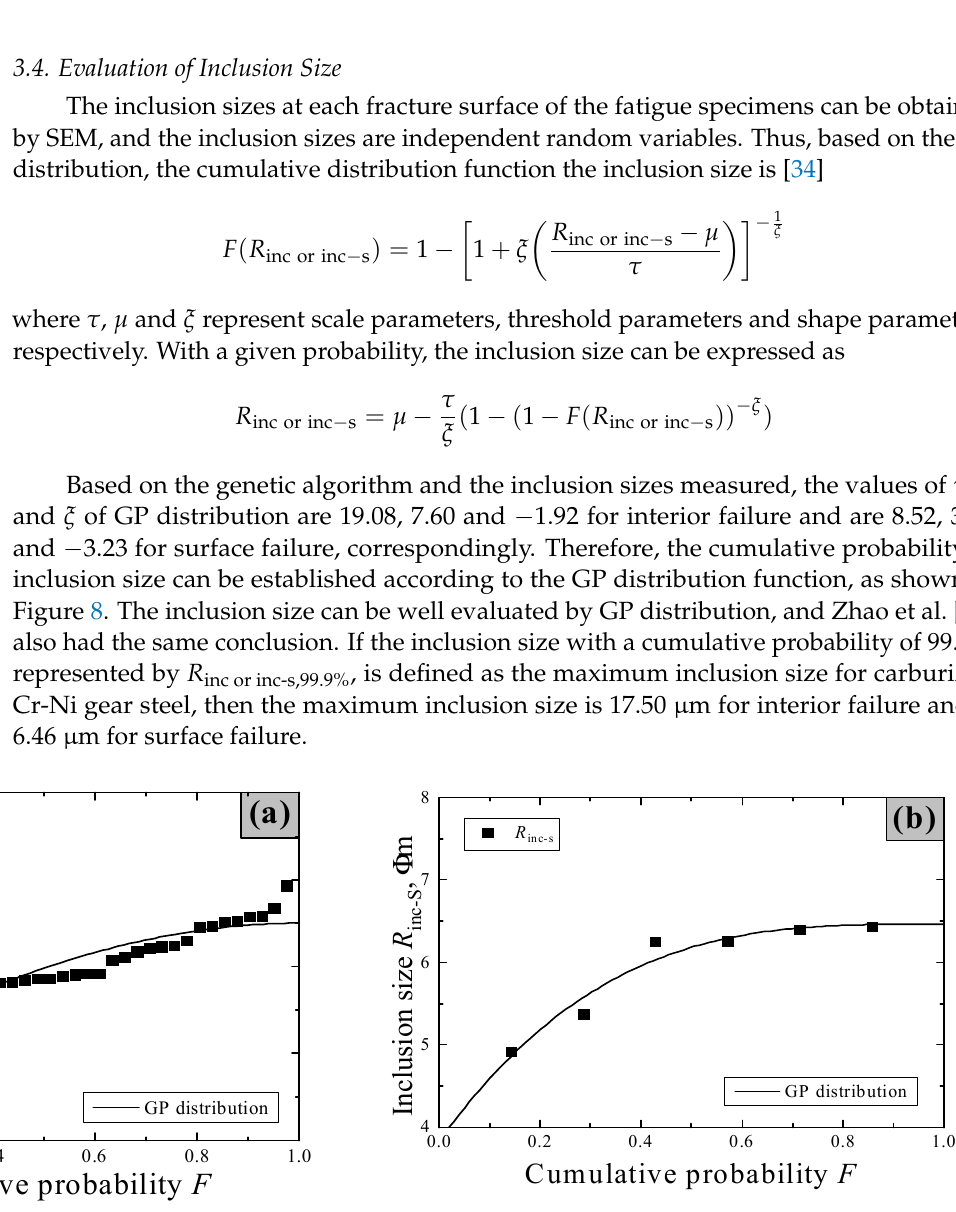
Figure 8. GP distribution of inclusion size: ( a ) interior inclusion size and ( b ) surface inclusion size.